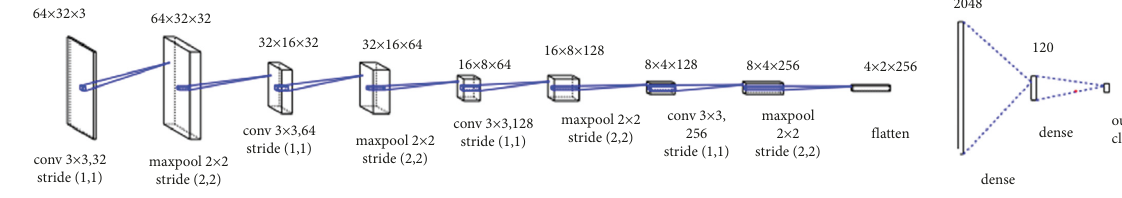
Figure 4: Architecture of the CNN model.